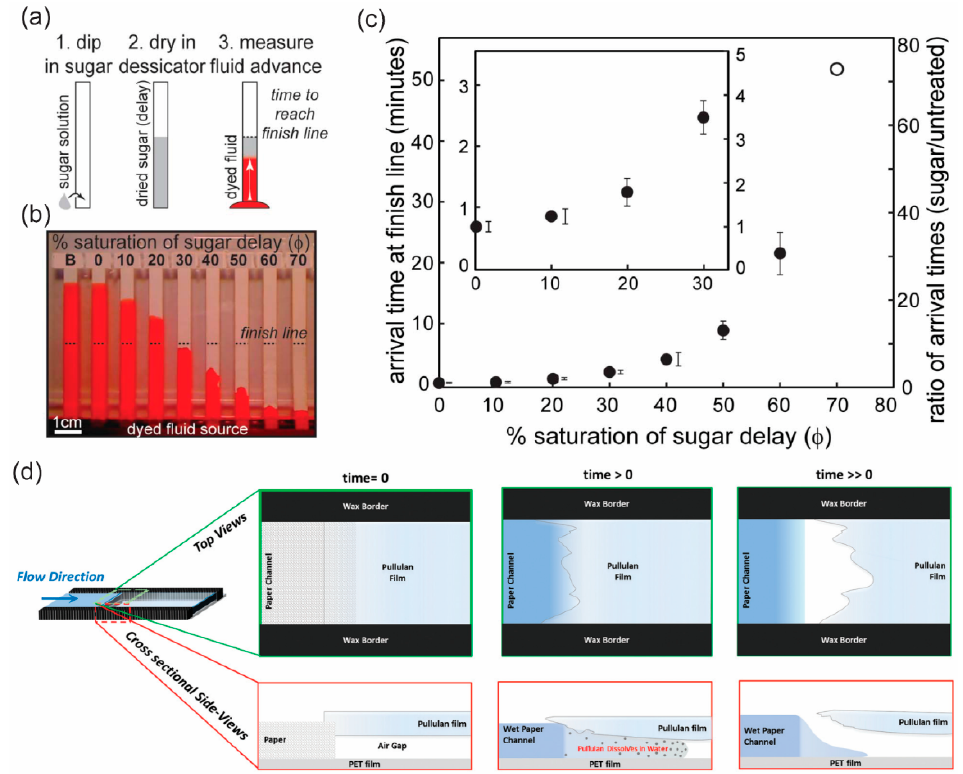
Figure 10. Delay of fluidic flow by incorporating a dissolvable material in a p-CFM device. ( a ) Schematic of a method for preparing a p-CMF device for which time delay is controllable. ( b ) Images of fluidic flow distances at specific times in paper channels modified with various concentrations of sugar. ( c ) Arrival time of fluid at the ends of channels versus the concentration of sugar used in the paper channels. Reproduced with permission from the authors of [81]. Copyright 2013 The Royal Society of Chemistry. ( d ) The pullulan film works as a dissolvable bridge to shut off the flow of liquid